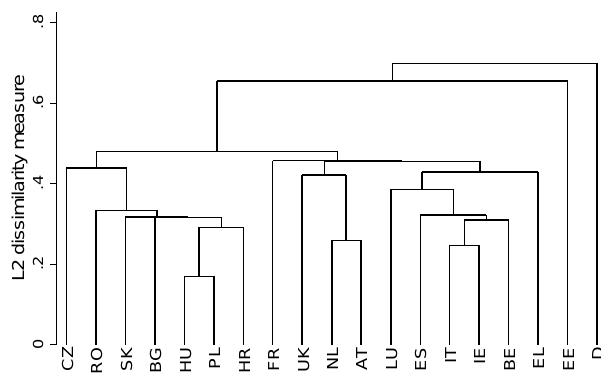
Figure 2. The result of grouping the countries using the 1-nearest neighbors algorithm for agglomerative clustering